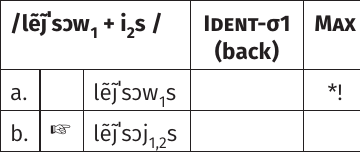
Table 3: Polysyllabic [lẽȷ̃ˈsɔw] fuses with the suffixal